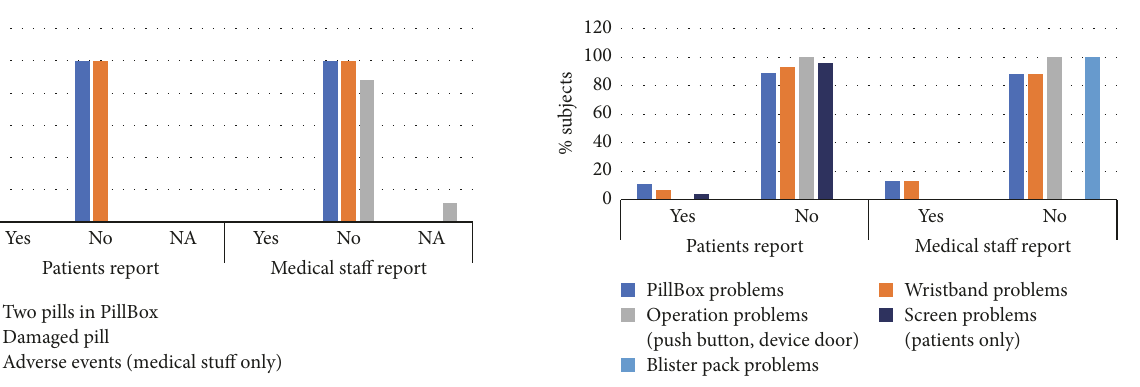
Figure 5: Summary of functional parameters of PCoA Acute. Both patients and medical staff were asked about problems encountered with the device operation, the PillBox, wristband, and screen. Only medical staff were asked for problems with insertion of blister pack. Data was obtained from patients and medical staff questionnaires and from the PCoA Acute log files.